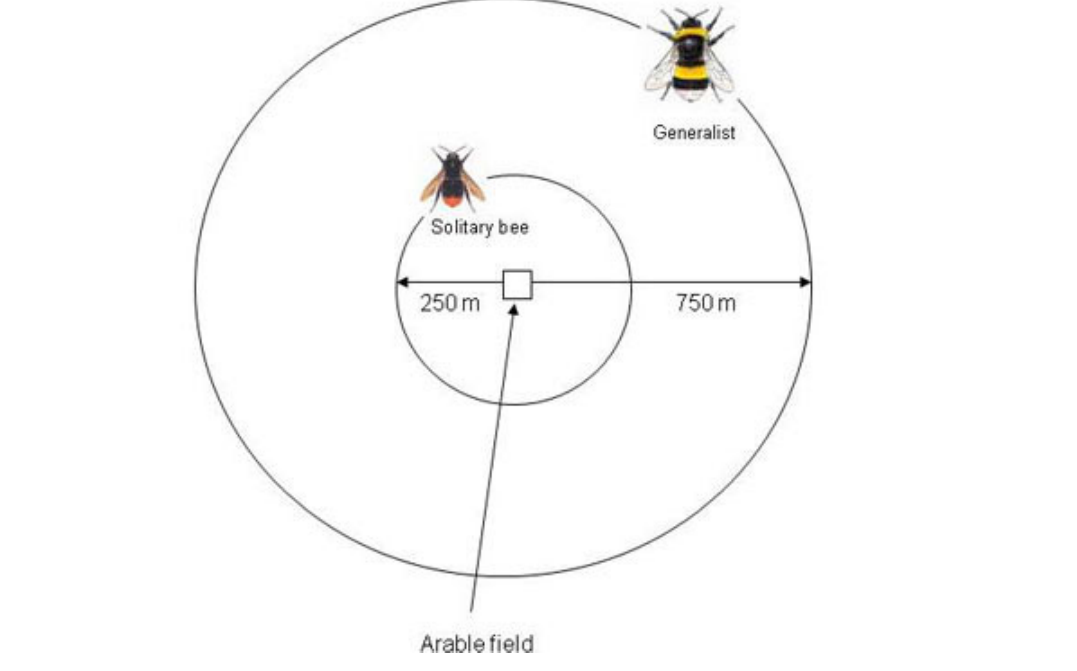
Fig. 3 . Scale of operation of solitary bees and wild bee generalists when presented